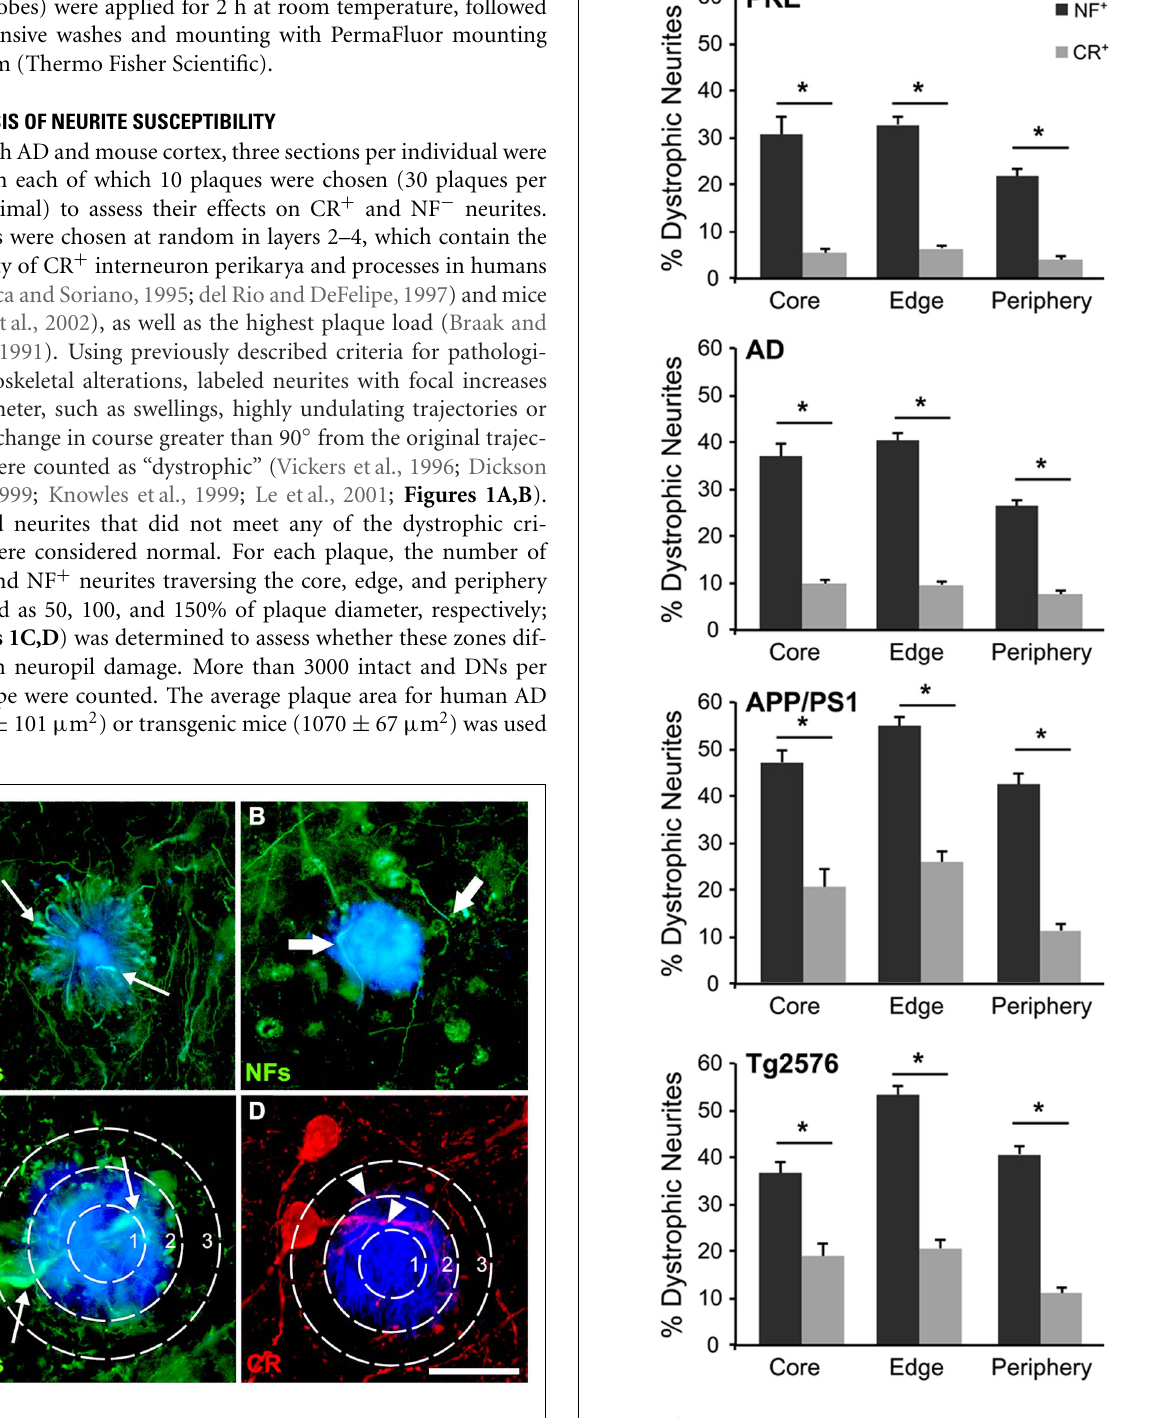
FIGURE 2 | Graphs illustrating the percentage of NF- (gray bars) and CR- (white bars) immunolabeled dystrophic neurites associated with fibrillarA β plaques at the three zones inAD, preclinicalAD,APP/PS1, andTg2576 transgenic mice, respectively ( ± SEM). There are significantly more dystrophic NF + neurites traversing the A β plaque core, edge, and periphery than CR + dystrophic neurites within all case types (* p < 0.05, t